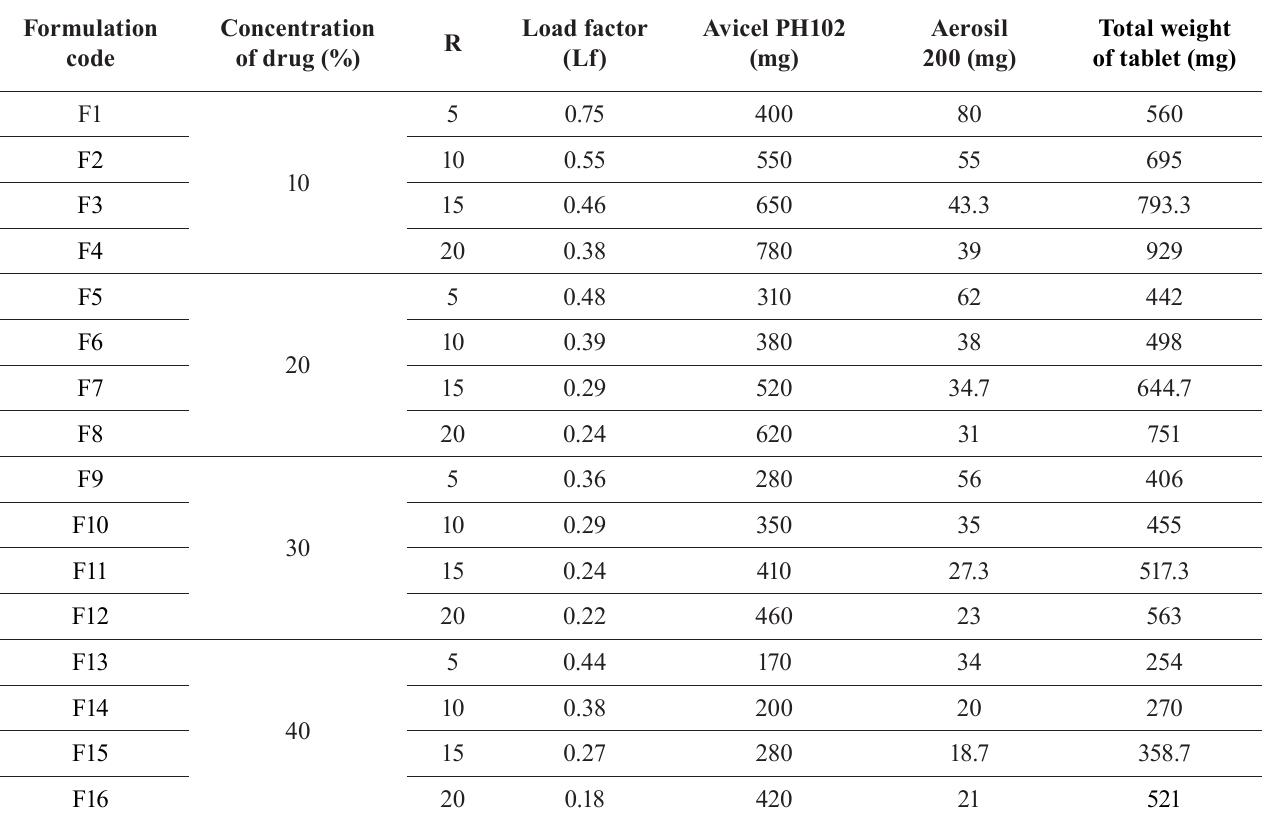
TABLE II - Formulations of liquisolid tablets